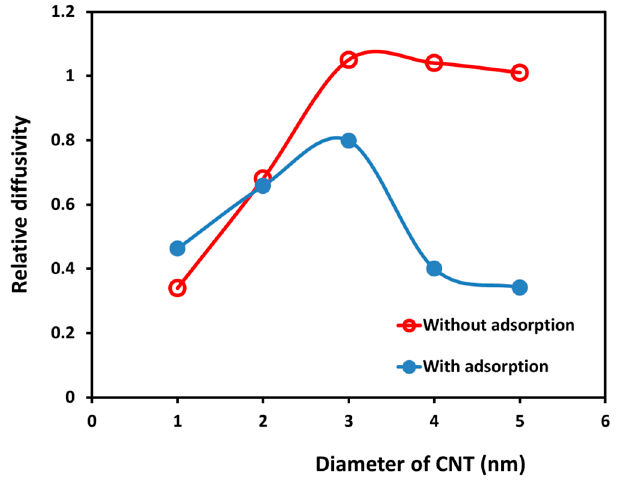
Figure 8. The relative diffusivity of water inside CNTs with different diameter with and without SDS adsorption. Relative diffusivity is the ratio of diffusivity of water inside the CNT to that in the bulk phase. The line in this plot is only used to connect the data and guide the eye to see the trend of changing relative diffusivity.